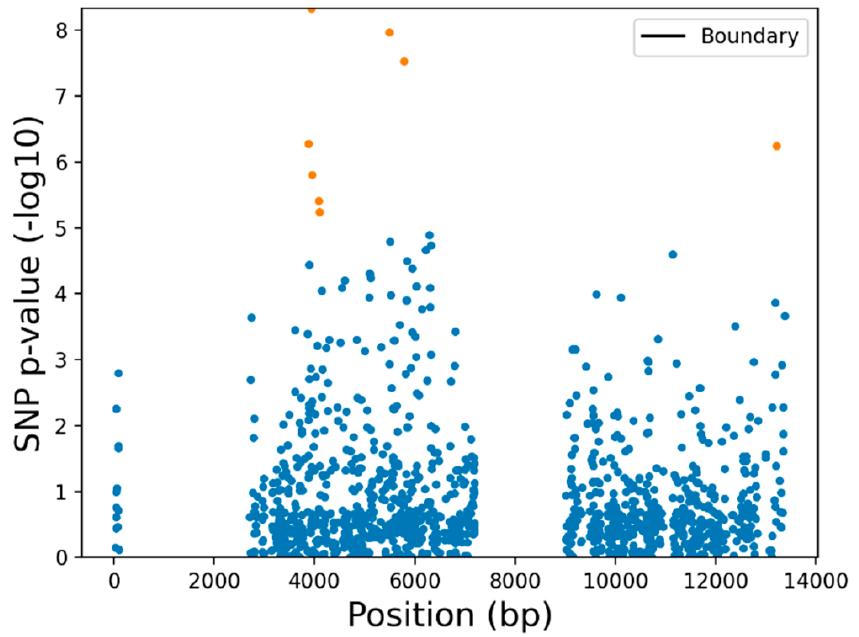
Figure 4. Manhattan plot of SNPs associated with PC2 (differentiating clusters of Sr and rr genotyped samples) on the filtered bi-allelic dataset (1333 variants).